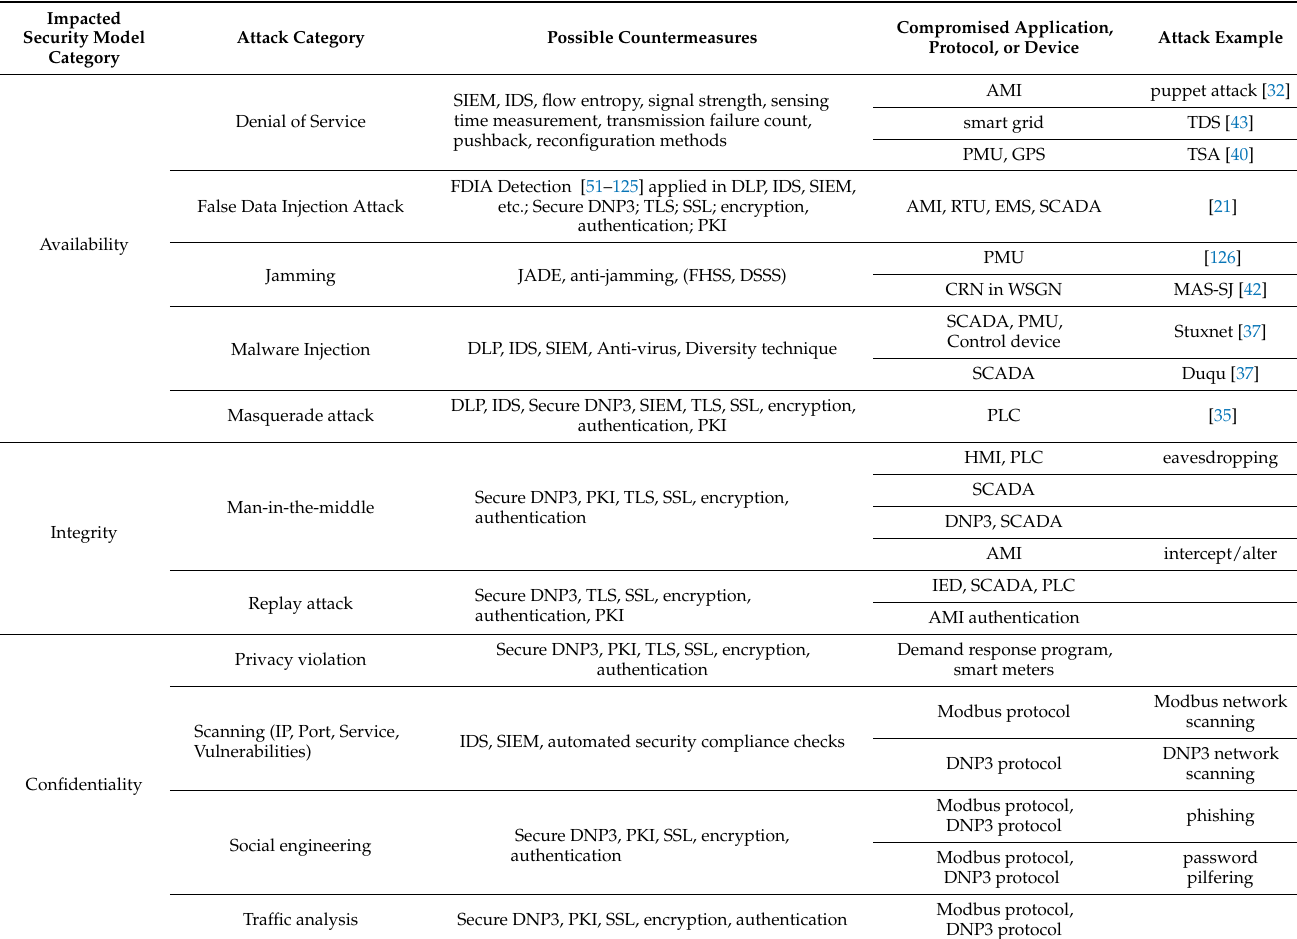
Table 2. Cyber Attacks in the Smart Grid and Their